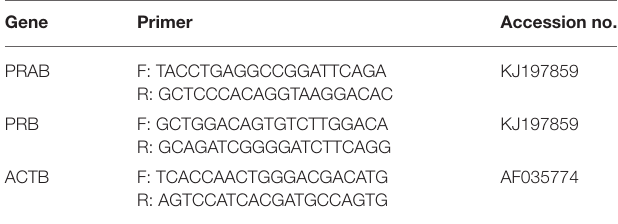
TABLE 1 | Sequences of the qPCR primers according to their accession numbers.